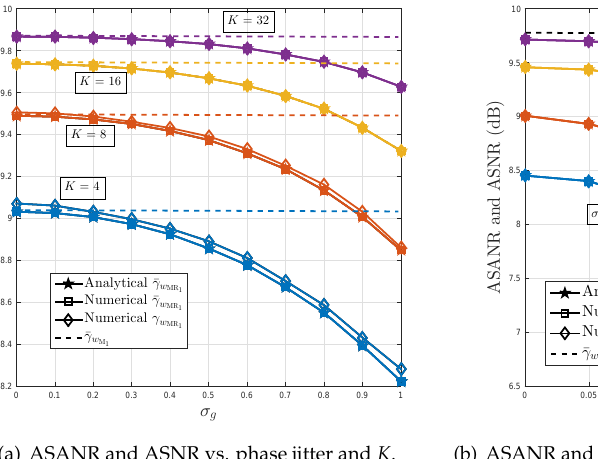
(b) ASANR and ASNR vs. localization errors for different levels of DoA estimation errors and K = 16. Figure 2. Average signal to average noise ratio (ASANR) and average signal to noise ratio (ASNR) of proposed monochromatic robust distributed collaborative beamforming (M-RDCB) in monochromatic environments under: ( a ) implementation Option 1, and ( b ) implementation Option